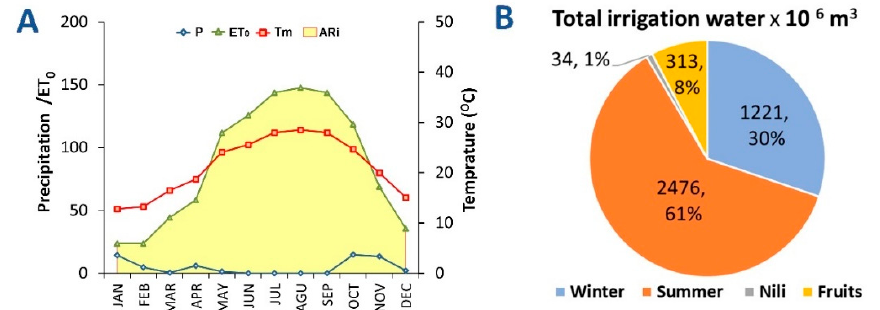
Figure 4. Volumetric climate graph of the representative metrological station for the studied area ( A ). Governorate by crop season ( B ). Tm: mean temperature in °C; ET 0 : potential evapotranspiration in mm; P: precipitation in mm; and Ari: aridity index. Pie chart shows the distribution of water irrigation quantity in the El-Sharkia.